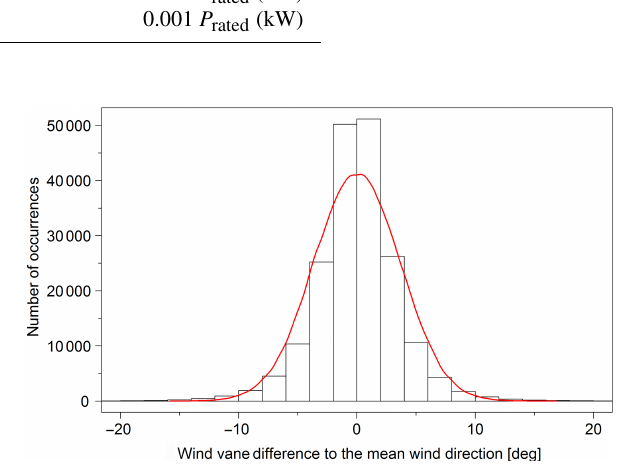
Figure 5. Layout of wind farm Ormonde. The 30 turbines of 5MW class are located in the Irish Sea 10km west of the Isle of Wal- ney. For a wind direction of 207 ◦ the single wake, double wake and triple wake behind OR26 have been selected as underperformance demonstration cases.